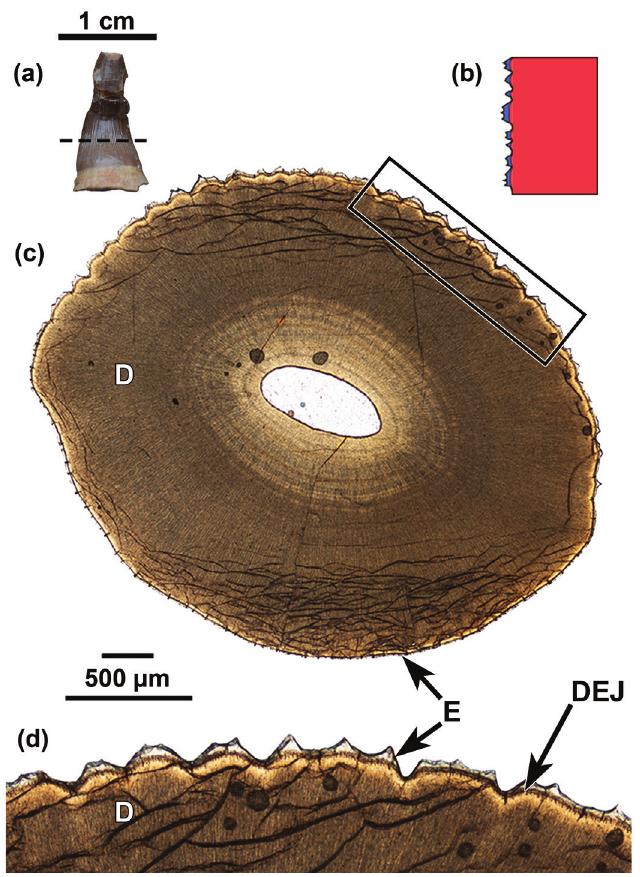
Figure 4. Anatomy of a striated Platecarpus tympaniticus tooth (UALVP 55497). A, tooth in lingual view with ap - proximate plane of section indicated by the dashed line; B, schematic diagram illustrating the relationship between the enamel (blue) and the dentine (red); C, transverse section seen under plane polarized light. Box indicates the region magnified in (D). D, close-up of the dentine-enamel junction viewed under plane polarized light. Abbreviations: D, den - tine; DEJ, dentine-enamel junction; E, enamel.